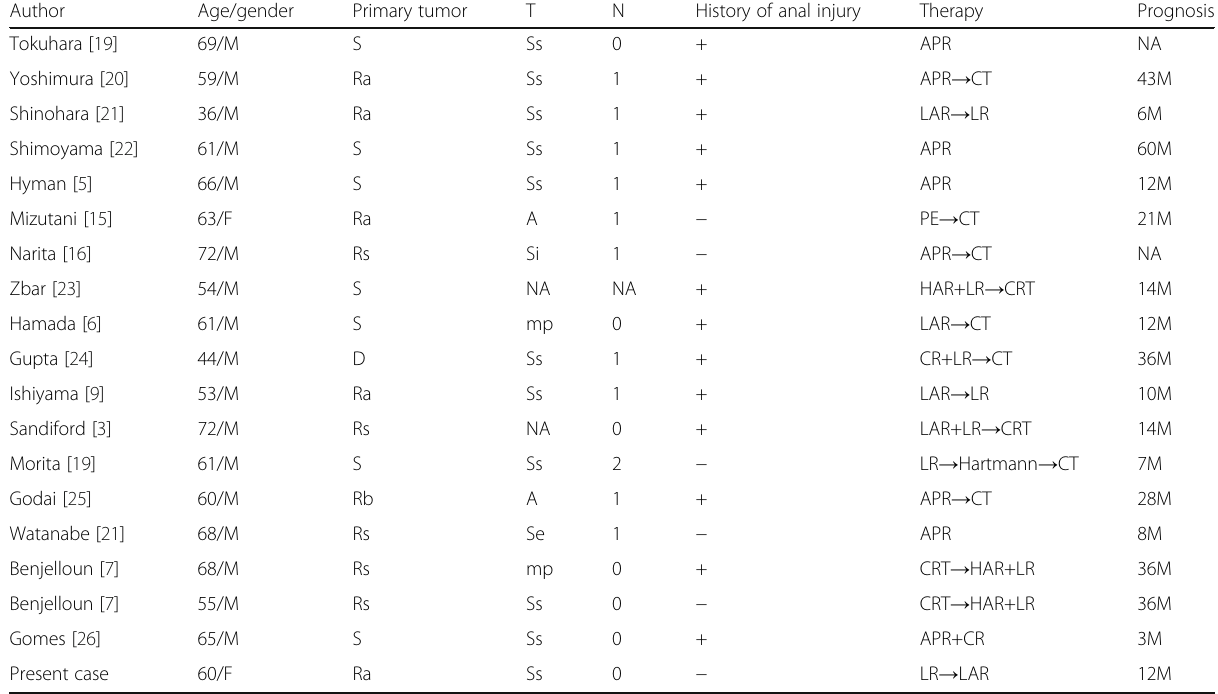
Table 1 Reports of synchronous anal metastasis of colorectal